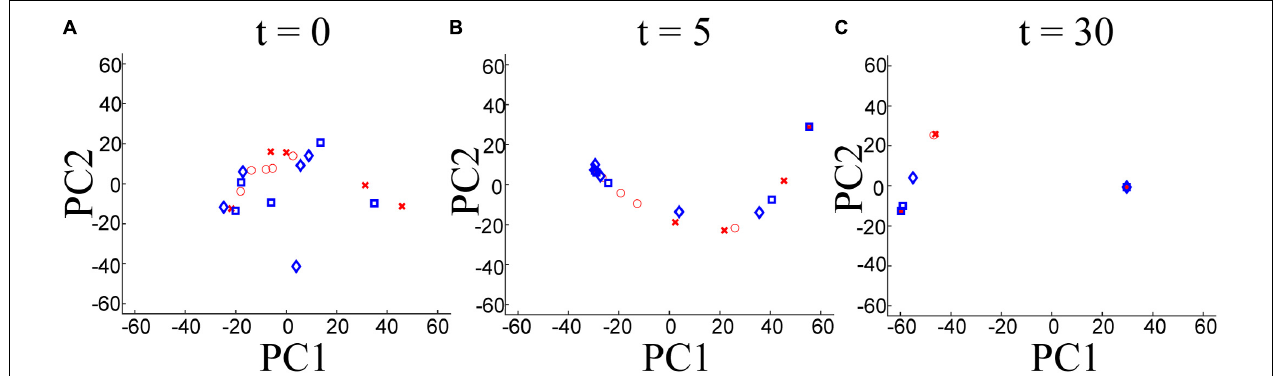
FIGURE 4 | Two-dimensional space of state vectors of Hopfield model obtained by principal component analysis (PCA) at (A) t = 0, (B) t = 5, and (C) t = 30. Red circles: Woman, red crosses: Japanese, blue squares: Dalmatian, blue diamonds: Poodle.